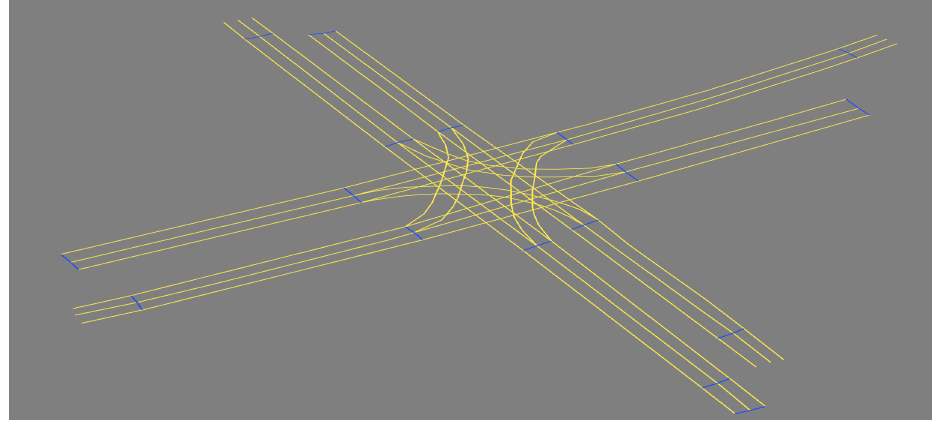
Figure 12. Loaded lanelet map in CoincarSIM